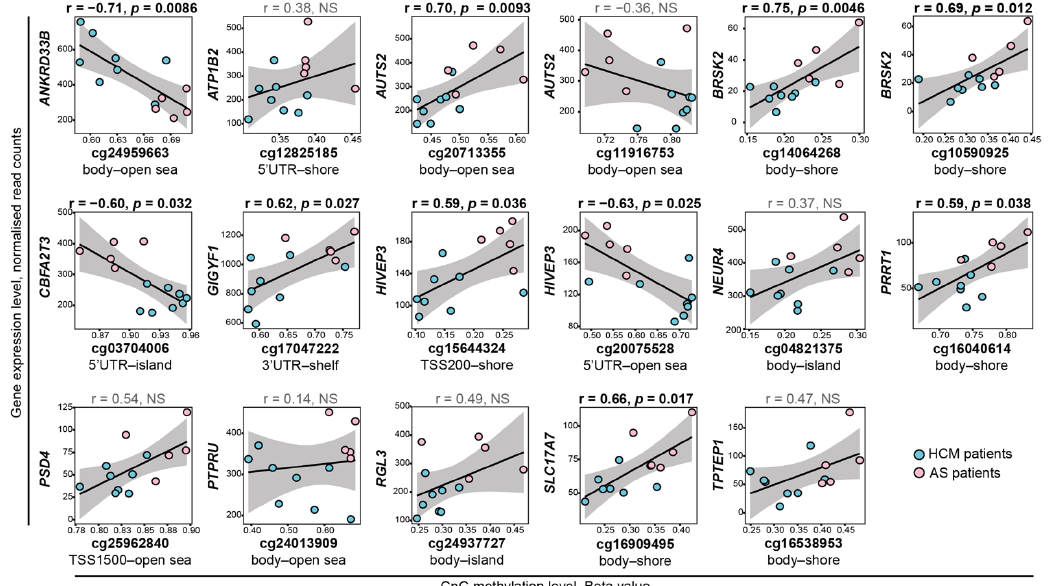
Figure 3. Correlation of expression of 14 DEGs with methylation levels of 17 neighboring DMPs. Cyan and pink dots represent HCM and AS patients, respectively. The black regression line and its confidential interval (gray area) are shown on each plot. Spearman’s rank correlation coefficients and p ‐ values calculated for each of the 17 DEG–DMP pairs are presented above corresponding dot plots. Significant coefficients and p ‐ values are marked in bold. Location of DMPs according to gene functional elements and CpG landmarks are indicated under each plot. TSS1500 and TSS200—regions within 1500 ‐ 200 and 200 ‐ 0 nucleotides upstream from the transcription start site (TSS), respectively; 5’UTR and 3’UTR—5 ′ and 3 ′ untranslated regions, respectively. NS—not significant.